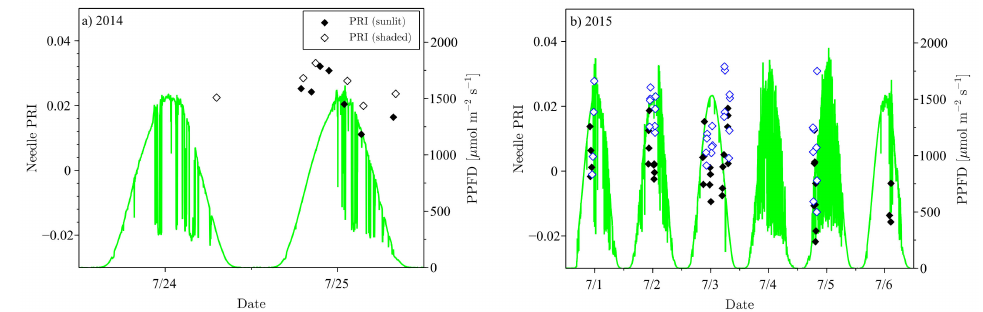
Figure 2. Needle PRI measurements (symbols, left axes) and top-of-canopy PPFD (right axes) during the two measurement campaigns in ( a ) 2014 and ( b ) 2015. On the horizontal axes, date numbers are located at the local solar noon.